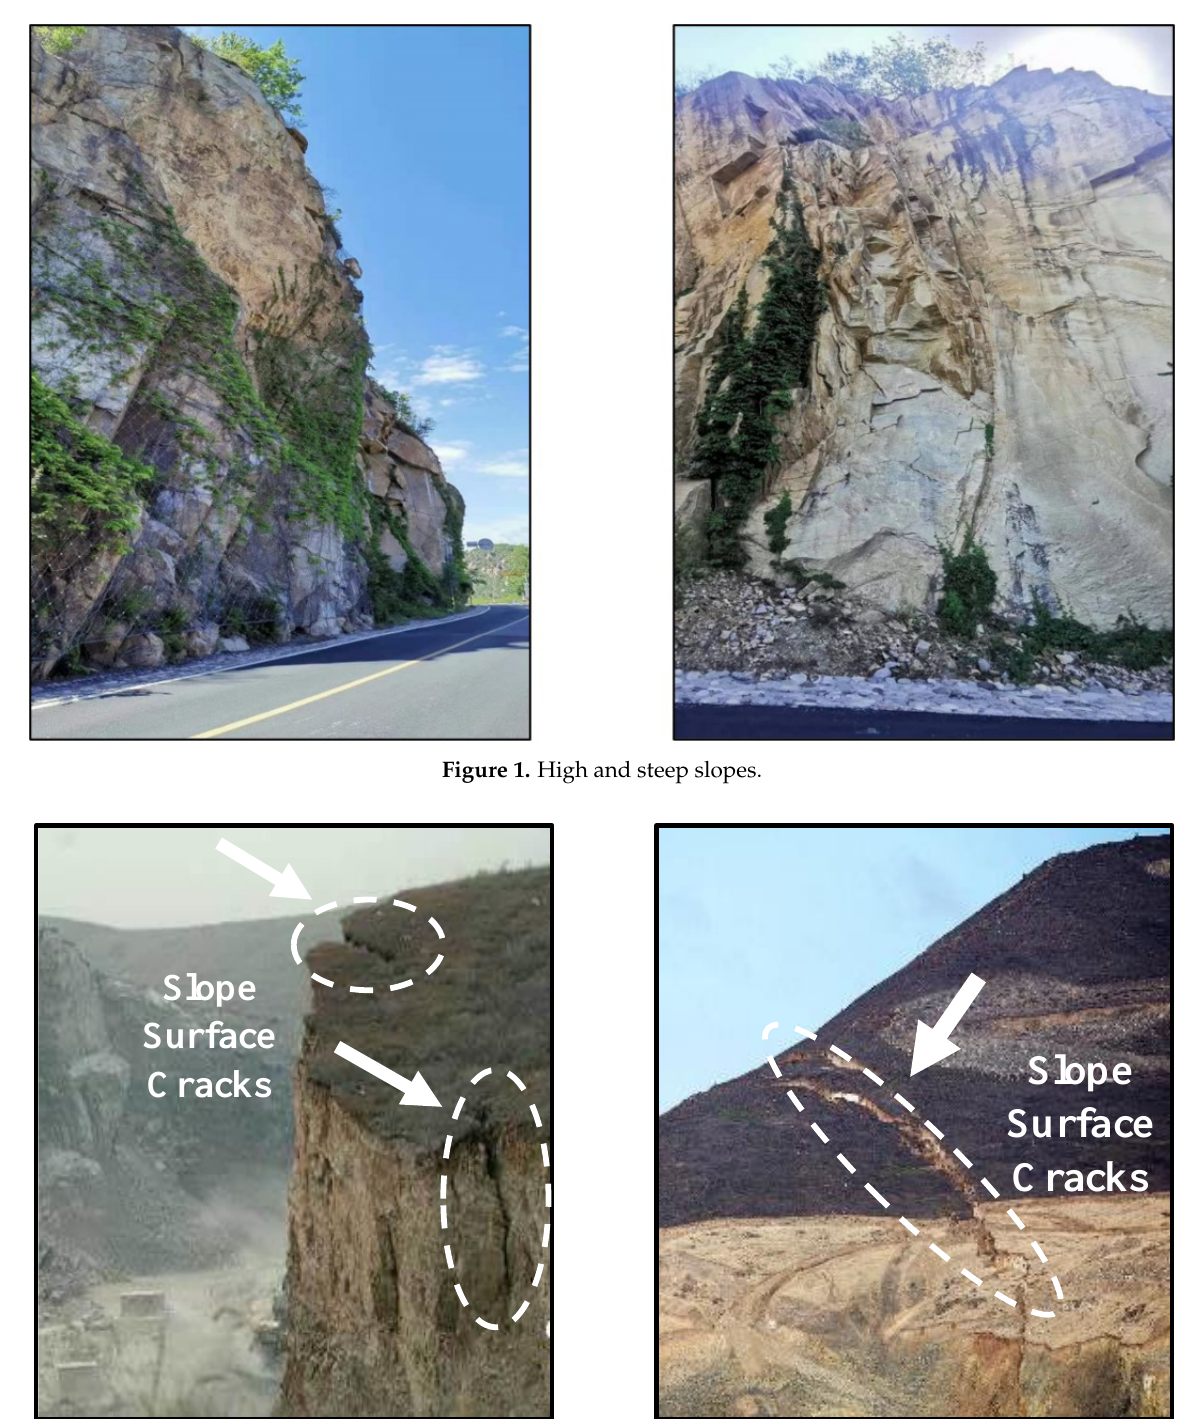
Figure 2. Real-world examples of slope surface